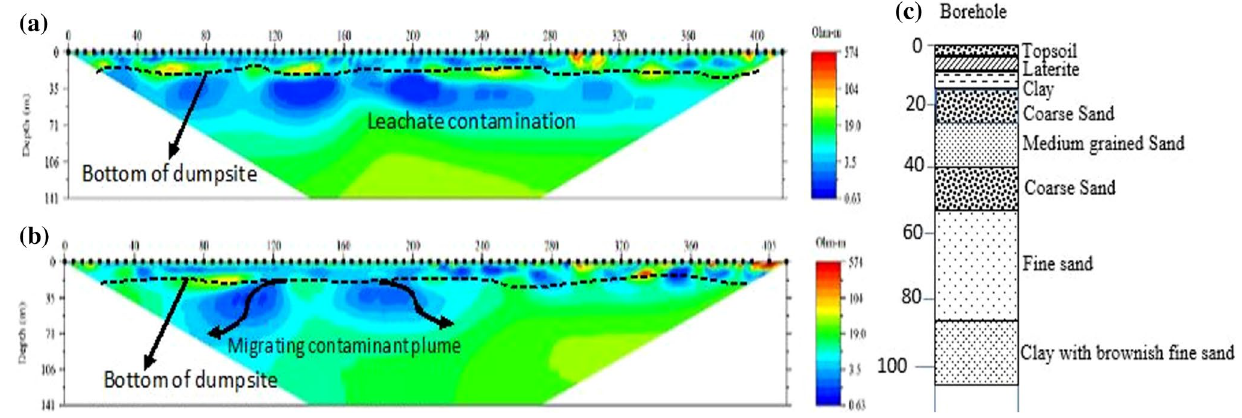
Fig. 4 Resistivity models obtained from the independent inversion of pole–dipole resistivity data measured in December 2014 ( a ) and pole– dipole resistivity data measured in December 2015 ( b